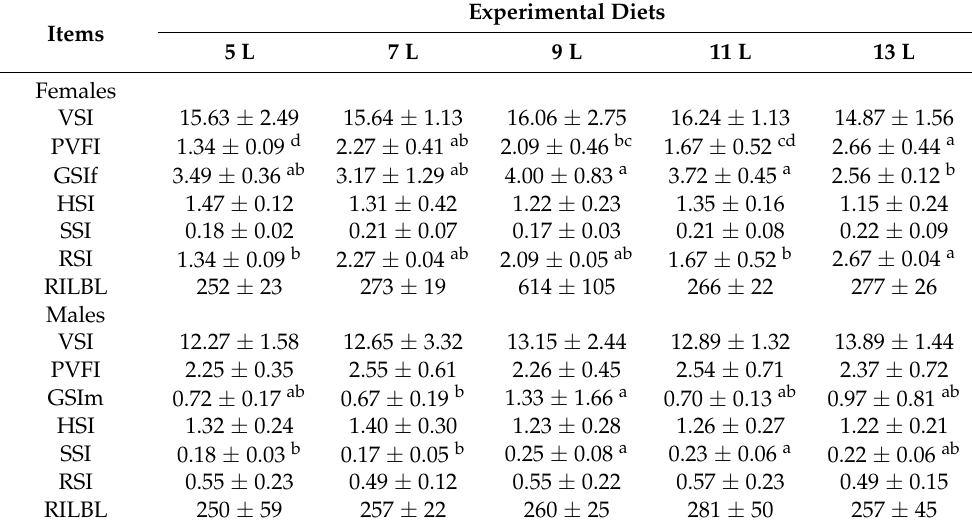
Table 5. The effect of different dietary lipid levels on somatic indexes in Onychostoma macrolepis broodfish ( n = 3;